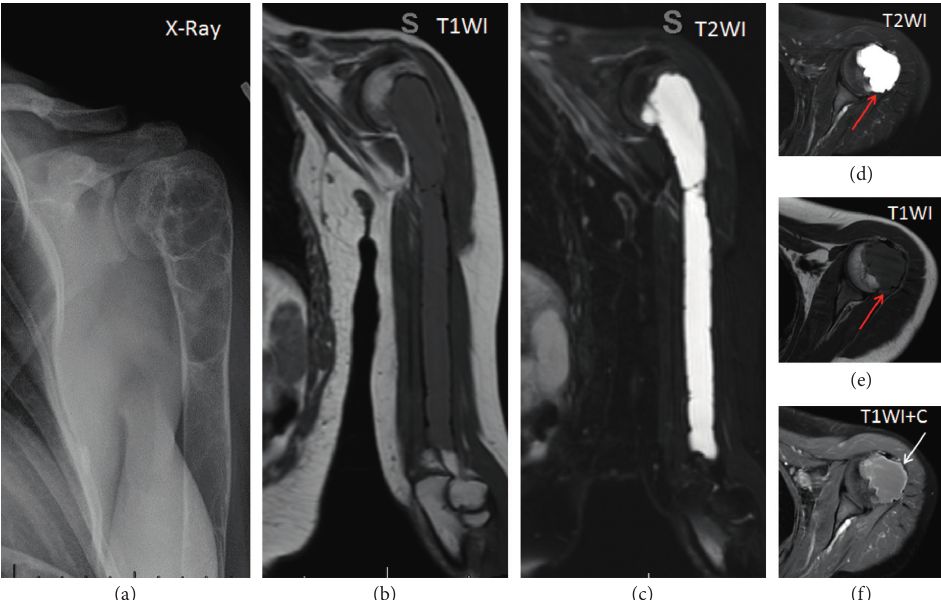
Figure 6: Left humerus brown tumor. X-Ray shows a large, well defined, multiloculated soap-bubbly lucent lesion. MRI T1W1 the lesion is similar to the muscle, on coronal and axial T2WI the lesion is hyperintense (very bright), axial T1WI without contrast the lesion is hypoinetense with prominent thinning of the cortical bone and minimal extension beyond the cortex (red arrows), axial T1WI +C with contrast and fat saturation shows diffuse and peripheral enhancement (white arrow).